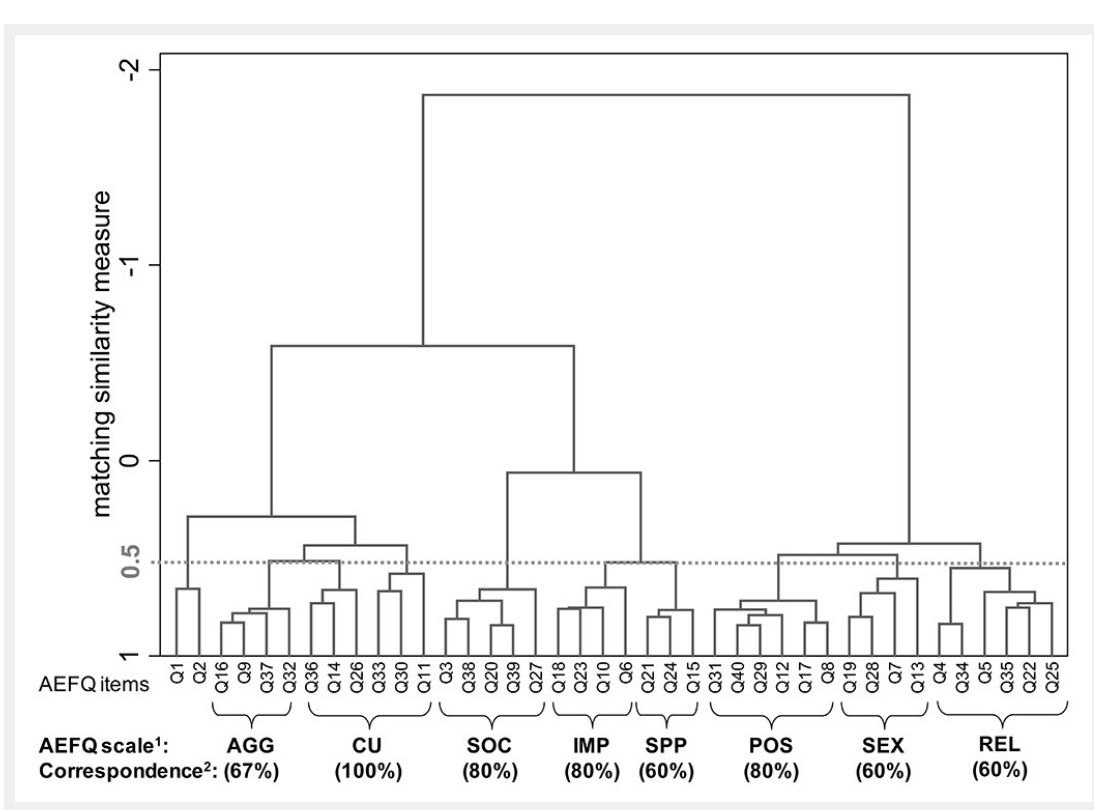
Cluster analysis dendrogram for the 40 items of the Alcohol Effects Questionnaire (AEFQ) – Ward’s linkage analysis. 1. AEFQ scales: Global Positive (POS), Social and Physical Pleasure (SPP), Sexual Enhancement (SEX), Power and Aggression (AGG), Social Expressiveness (SOC), Relaxation and Tension Reduction (REL), Cognitive and Physical Impairment (IMP), and Careless Unconcern (CU). 2. Correspondence, for each scale, between the variables clustered by our analysis and those originally retained in the validated AEFQ. Note for the interpretation of this figure: the matching similarity measure (y axis) evaluates the degree of clustering of AEFQ items (x axis). For example, concerning the SOC score, we can see that the items Q3 and Q38 are strongly clustered with each other, like Q20 and Q39. Under a 0.5 threshold, we observe that Q3, Q38, Q20, Q39 and Q27 constitute a same cluster. Among these items, four belong to the SOC scale of the originally validated AEFQ that includes itself five items (correspondence of 4/5 or